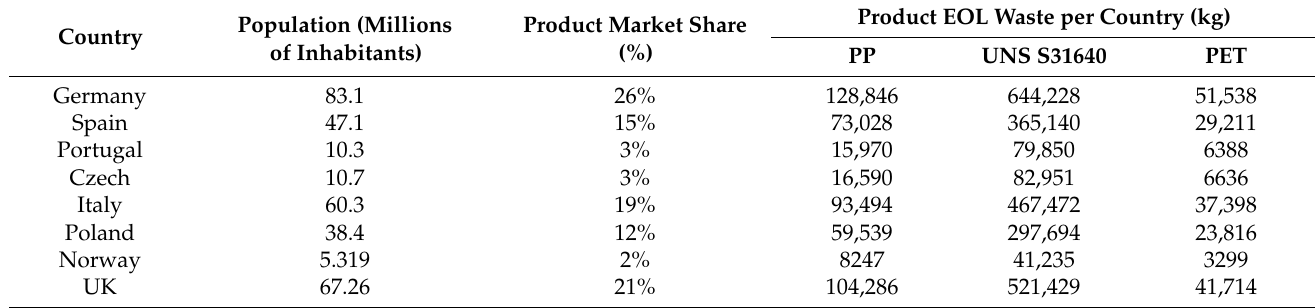
Table 29. Waste split according to the sales market and the material that composes the product as well as its packaging [80,81]. Population Country